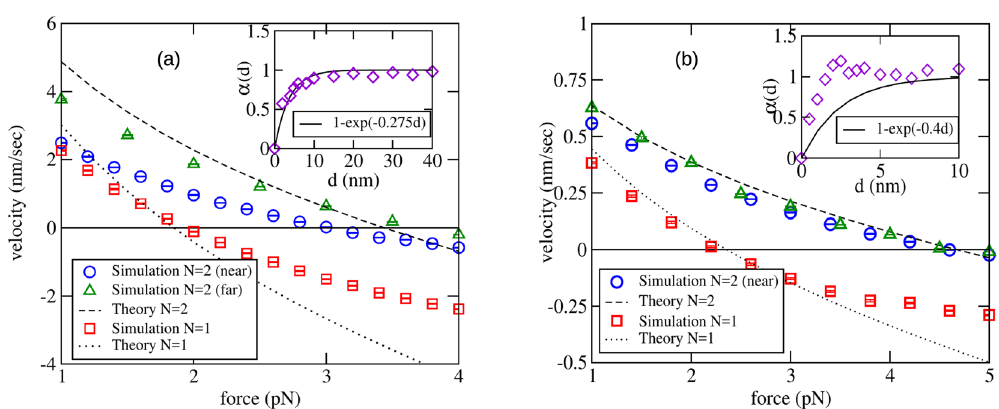
Figure 4. The force-velocity curve for a single filament versus two filaments, obtained from Brownian dynamics simulations, for ( a ) a = 10 nm and ( b ) a = 2 nm. For ( a ), the off-rate of monomers is k off = 2 s − 1 while for ( b ), k off = 0.2 s − 1 . Analytical results are shown for best fit value of λ ; 0.275 nm − 1 in ( a ) and 0.4 nm − 1 in ( b ). In the insets, fits for (scaled) separation-dependent on-rate α ( d ) = k on ( d )/ k on ( ∞ ), using the same λ are shown. The other parameter values are given in Table 1. Here, near means zero base separation between polymers, wheras far refers to a base separation 10 a . The error bars are typically smaller than the size of the